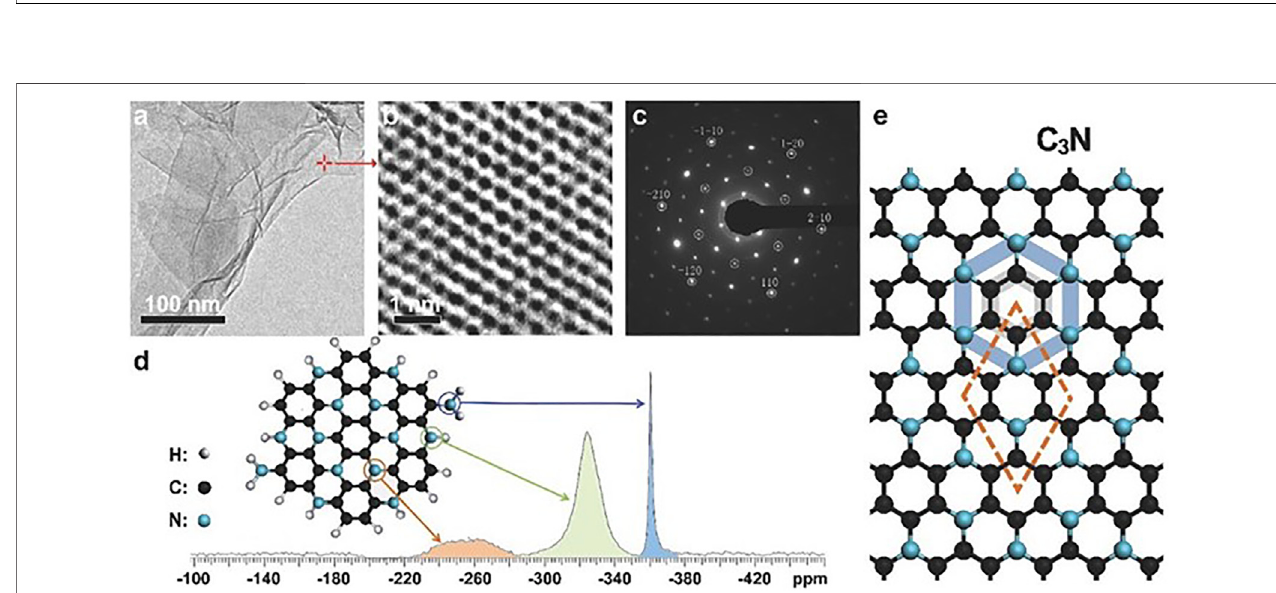
FIGURE 7 | Structure of C 3 N sheets. (A) TEM image of a mixture of single- and multilayer C 3 N sheets. (B) Spherical aberration-corrected HRTEM image showing the honeycomb structure of a single-layer sheet marked in (A) . (C) SAED indicating the D6h-symmetry of N and C atoms in the single-layer C 3 N sheet. The circles mark thegraphenespotsandtheadditionalspotsareduetothesupercelloftheC 3 Ncrystal. (D) 15 N-NMRspectrumofamixtureofsingle-layerandmultilayerC 3 Nsheets.The assignmentofthepeaks tospeci fi cNatoms intheC 3 Ncrystalisindicated. (E) Themolecular structure and supercelloftheC 3 Ncrystal.Theblueand blackregular hexagons show the D 6 h-symmetry of N and C atoms in the C 3 N crystal, respectively. Reproduced with permission from Yang et al. (2017).